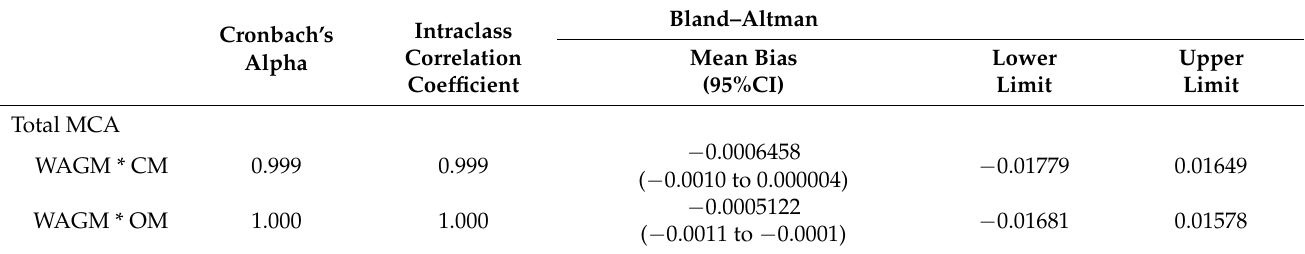
Table 3. Reliability and Bland–Altman agreement analysis (mean bias and 95% limits of agreement) between the MCA total scores). Comparisons of the Configural Model and the Overall Model procedures with the Weighted Age Group